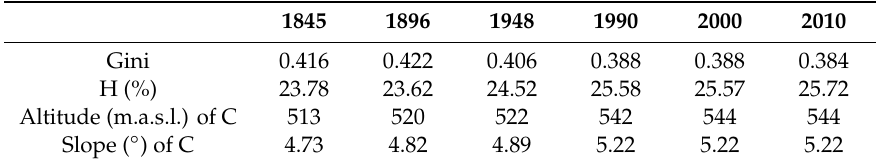
Table 5. Changing distribution of forests: Gini, H, average altitude, and slope for the concentrated half of BTUs